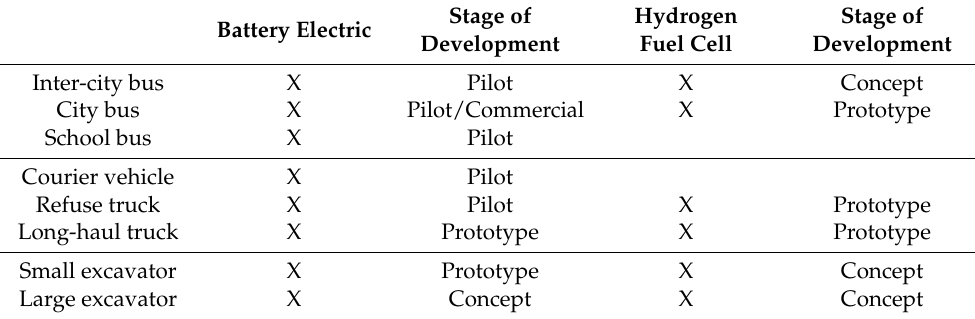
Table 2. Vehicle use cases and clean technologies evaluated (marked as “X”), with stage of